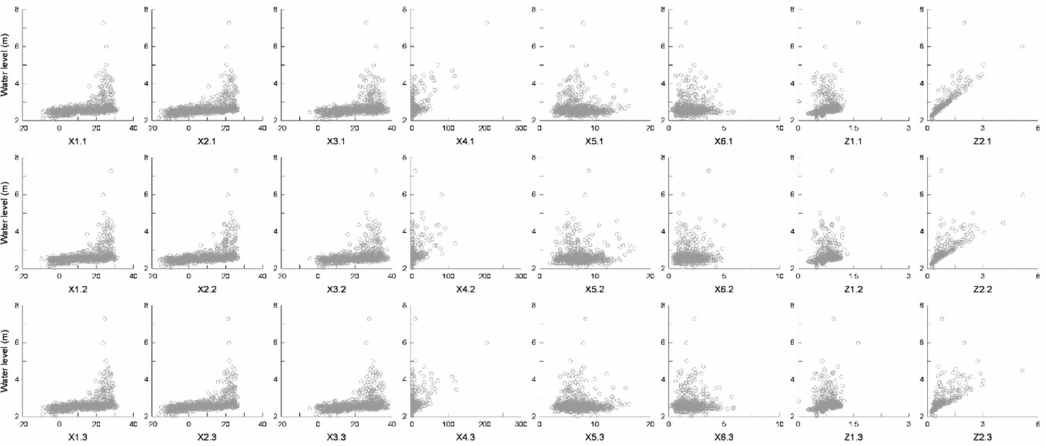
Figure 5. Scatter plots of independent and dependent